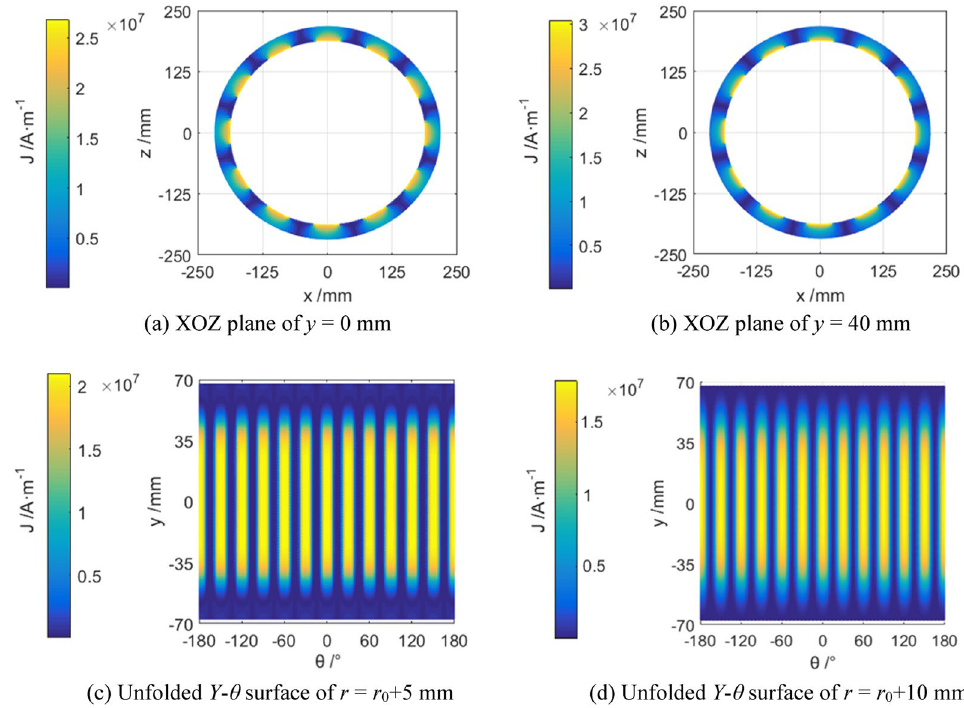
Figure 3. Simulated current density J in the